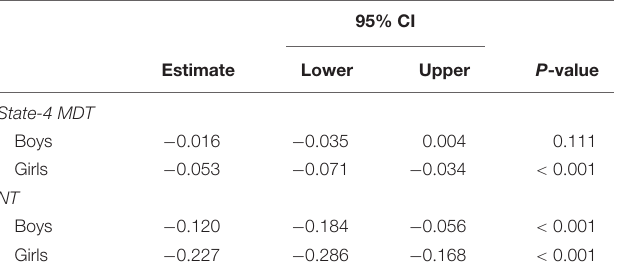
Linear mixed-effects models (random effect: subject). The MDT outcome was transformed using Box–Cox. Age was centered to the mean age of the sample at age-10